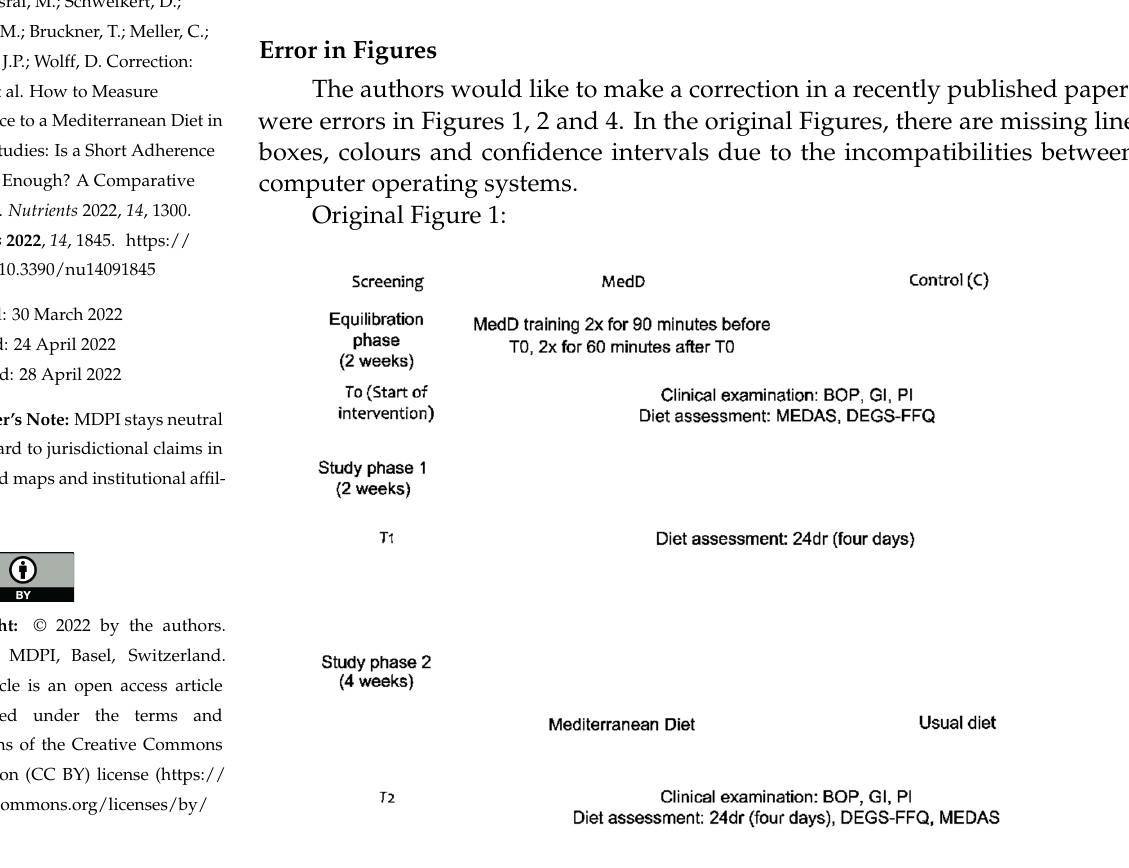
Original Figure 2: Equilibration phase (2 weeks) Mediterranean